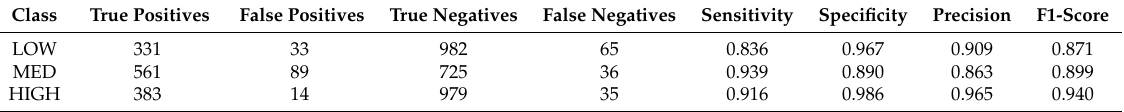
Table 13. Additional metrics obtained for Valence (Test) classification with the GSR + ECG system.